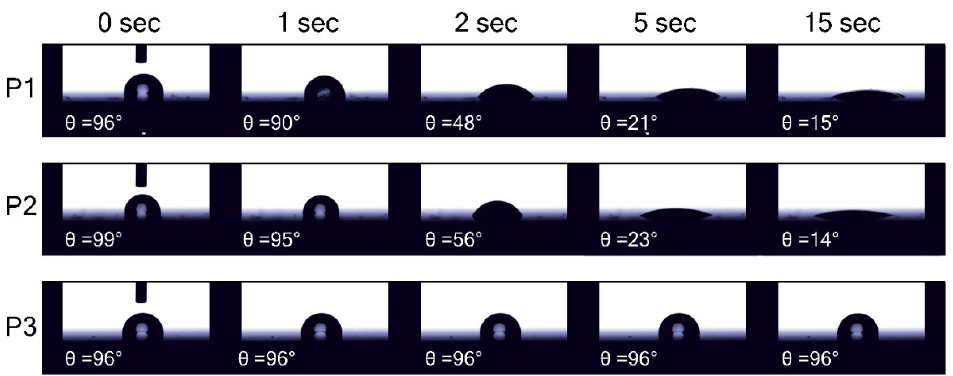
Figure 5. Changes of contact angle of water on perovskite/HTM sample.